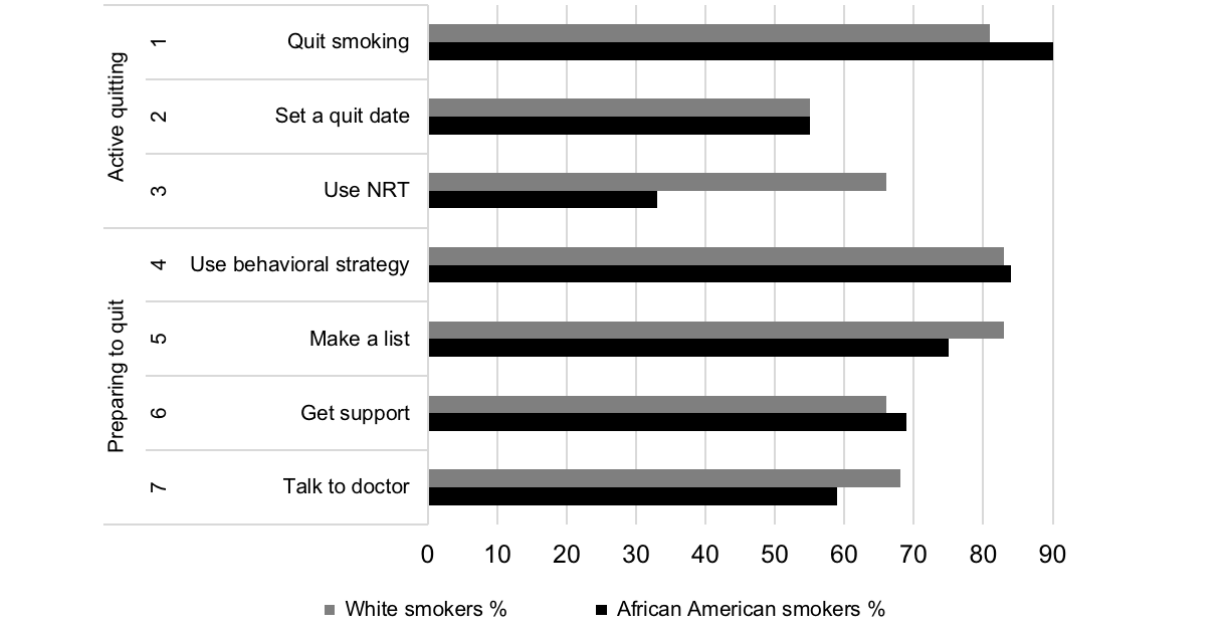
Figure 3. Perceived influence on quitting strategies between African-American and white people who